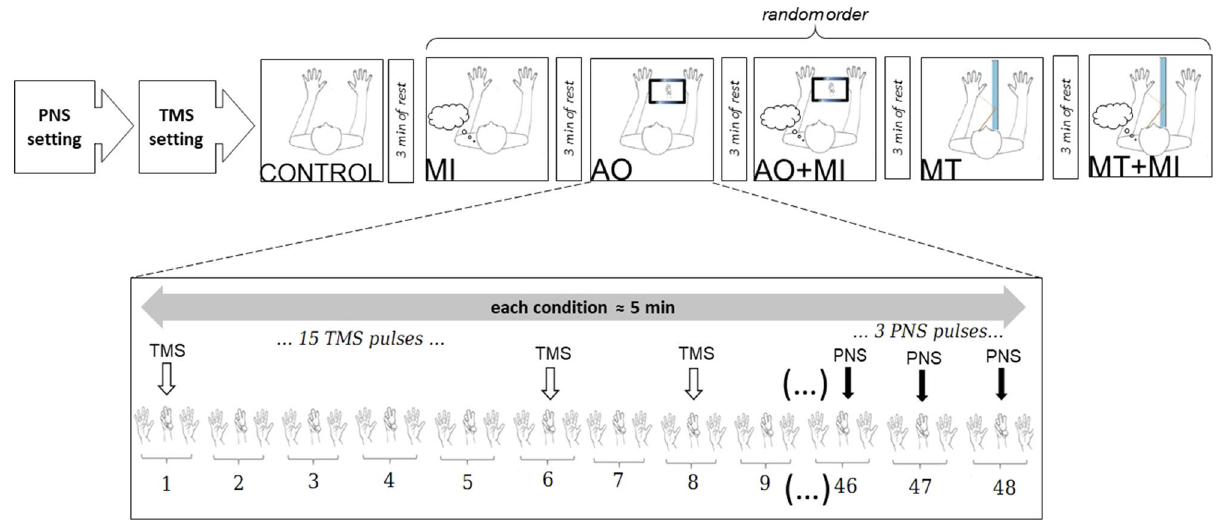
Figure 1. Overview of the experimental protocol. Series of fifteen magnetic (white arrows) and three peripheral nerves stimulations (black arrows) were performed for each condition about approximately five minutes (MI, AO, AO + MI, MT, MT + MI) separated by three minutes of rest. Control condition was performed at the beginning of the